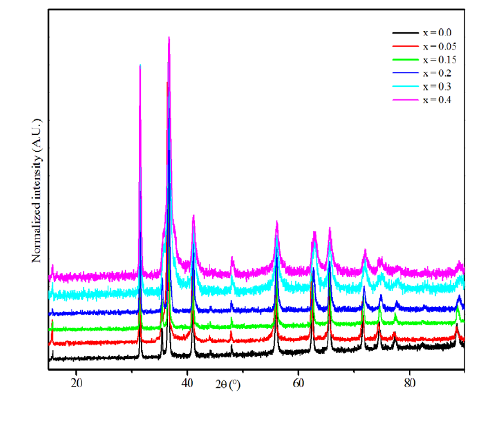
Figure 1. Room temperature XRD patterns of CuCr (0 ≤ x ≤ 0.4) Table 1. Cell parameters evolution with Al